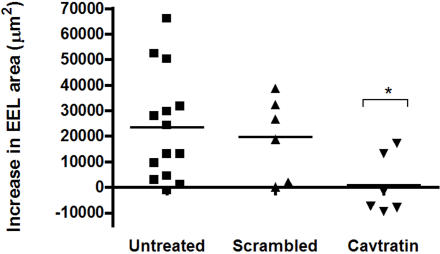
Cavtratin and Expansive Remodeling.Increase in EEL area (µm2) of the left carotid arteries (contralateral arteries) after ligation of the right carotid artery in BALB/c (n = 14) (circles), BALB/c+scrambled (1.5 mg/kg/day) (n = 6) (squares) and BALB/c+Cavtratin (1.5 mg/kg/day) (n = 6) (triangles). *p = 0.02